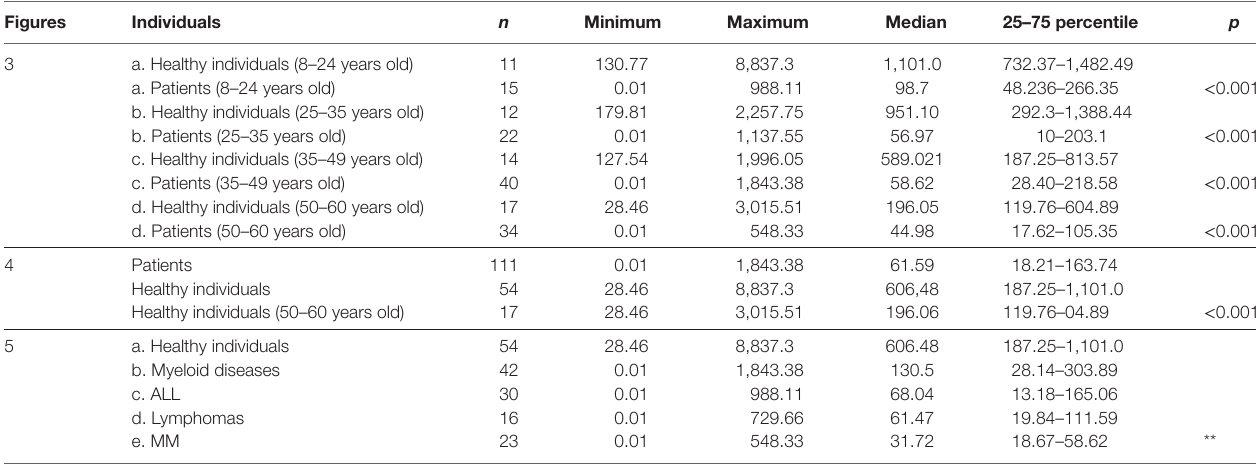
Table 3 | Signal joint TREC copies/ μ g DNA (according to Figures 3 – 5 ).